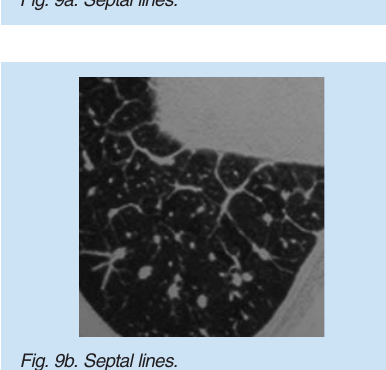
Fig. 7a. Mosaic pattern due to air-trapping.